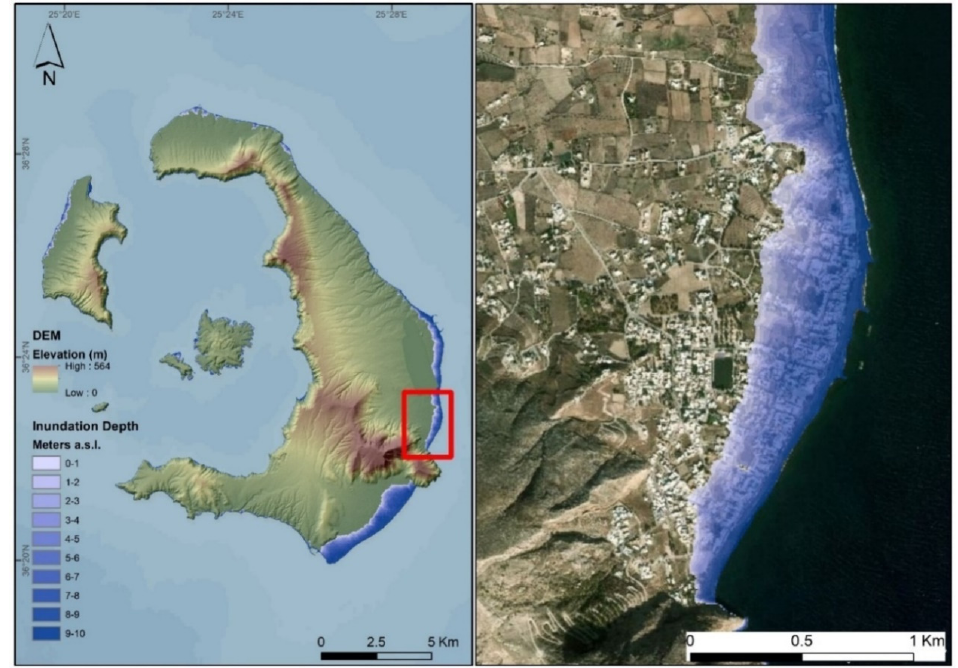
Figure 4. The inundation zone after a 10 m tsunami run-up in Santorini (left) and in Kamari (right). Table 1. Number of buildings per inundation depth.